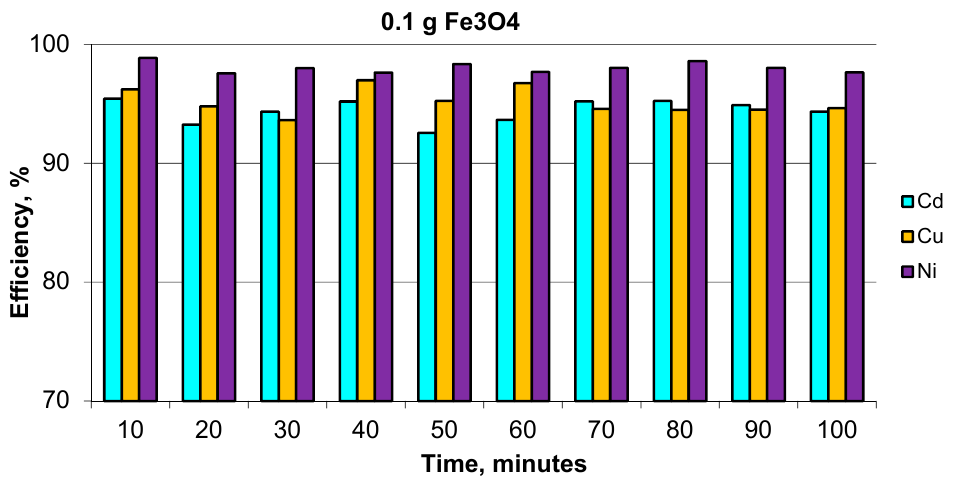
Figure 14. Removal efficiency of Cd, Ni and Cu for ION.